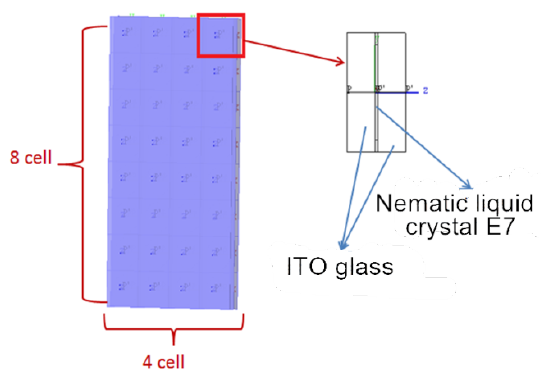
Figure 8. Design structure for a single liquid crystal lens and the liquid crystal lens array.